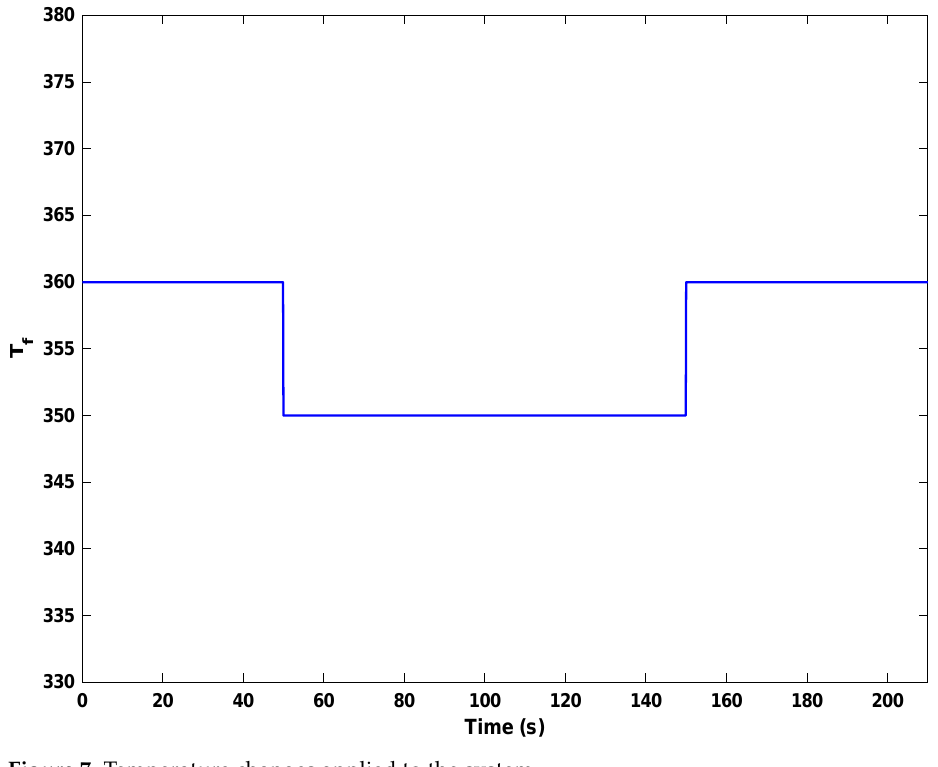
Figure 7. Temperature changes applied to the system.